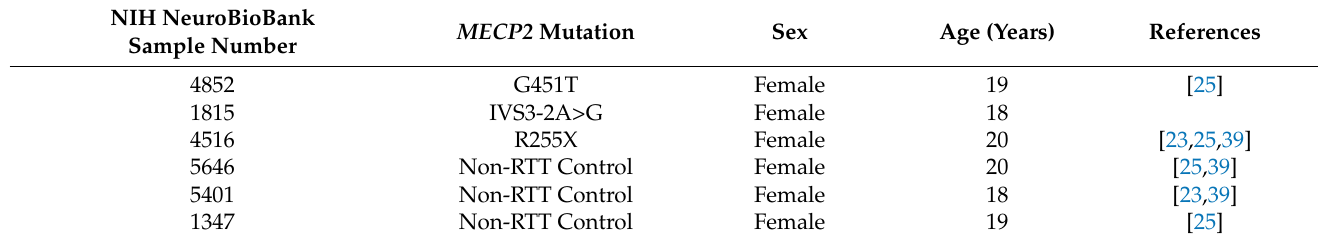
Table 4. Characteristics of Rett Syndrome patients and